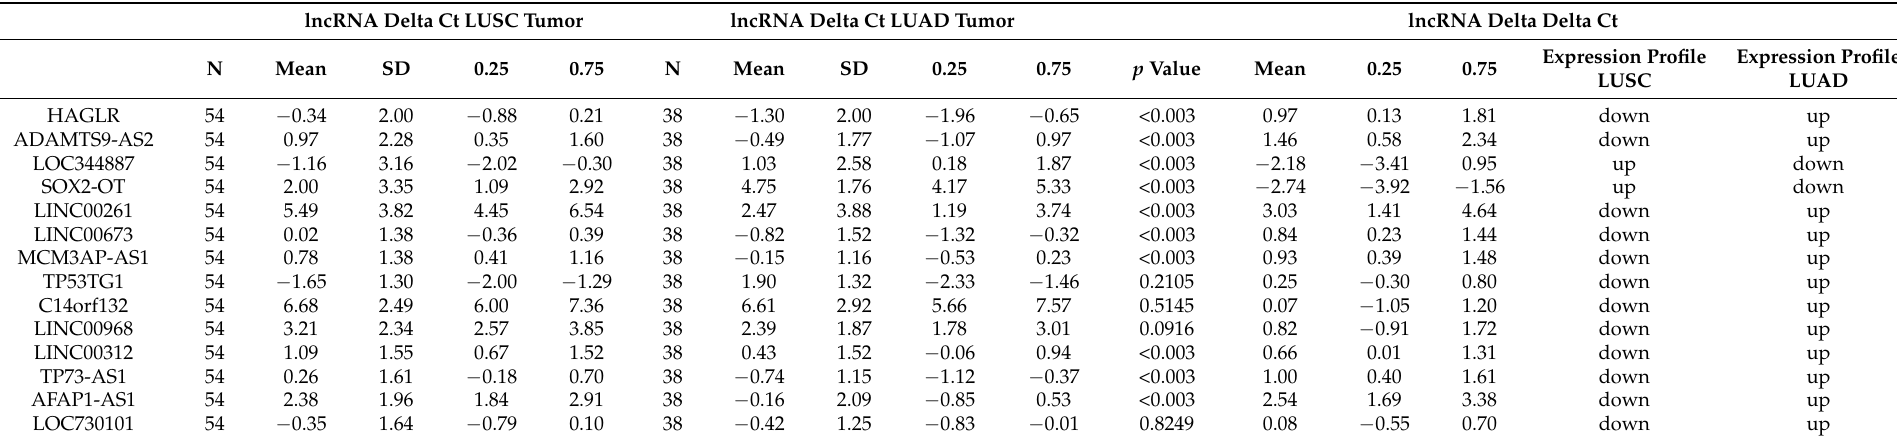
Table 4. Expression of 14 lncRNA in LUAD tumor vs. LUSC tumor.